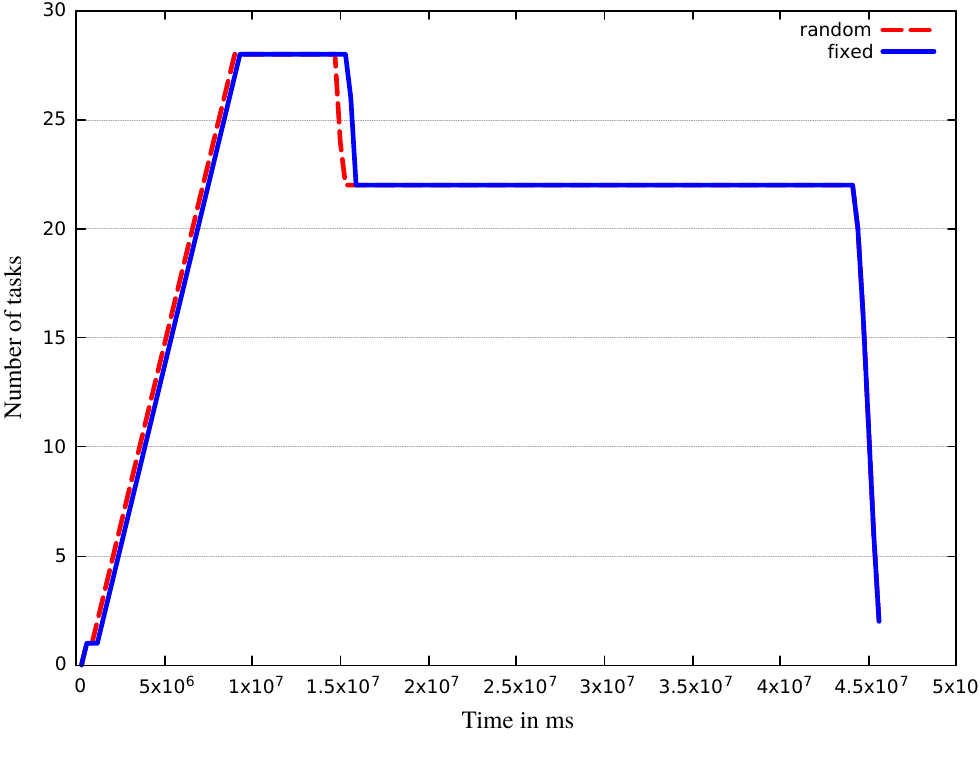
Figure 9. Results of scenario N o 2.